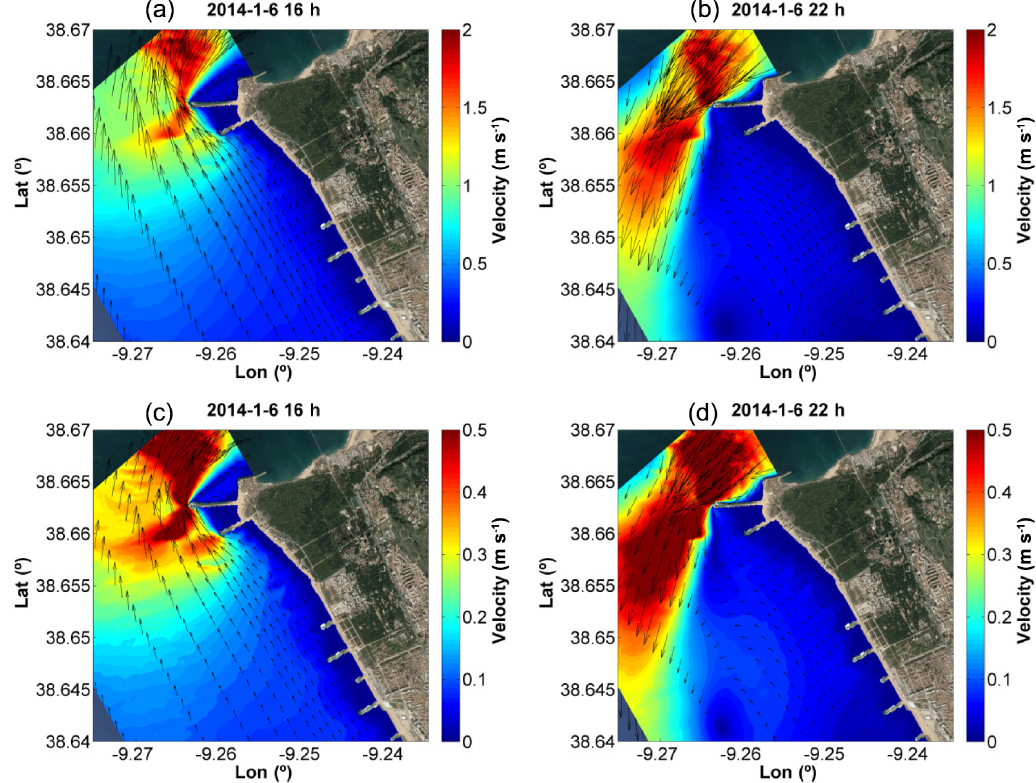
Figure 12. Velocity results of the Costa da Caparica model during flood (a, c) and ebb (b, d) tides at the surface (a, b) and near the bottom (c, d) without considering the wave’s effect on the hydrodynamics.